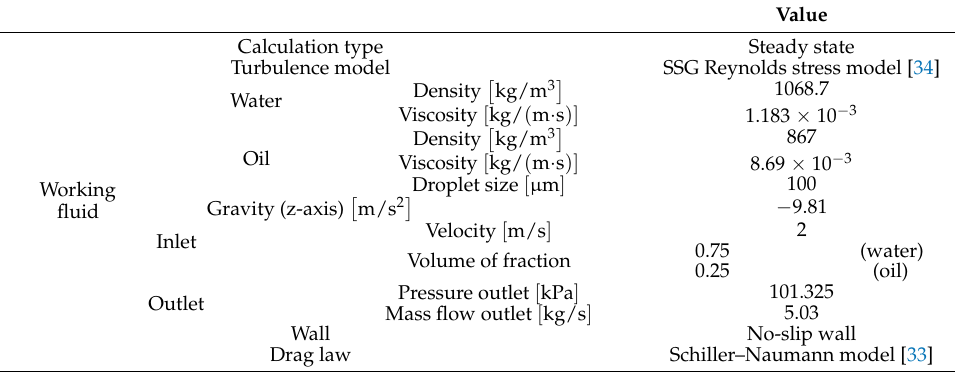
Table 2. Boundary conditions applied in this study.